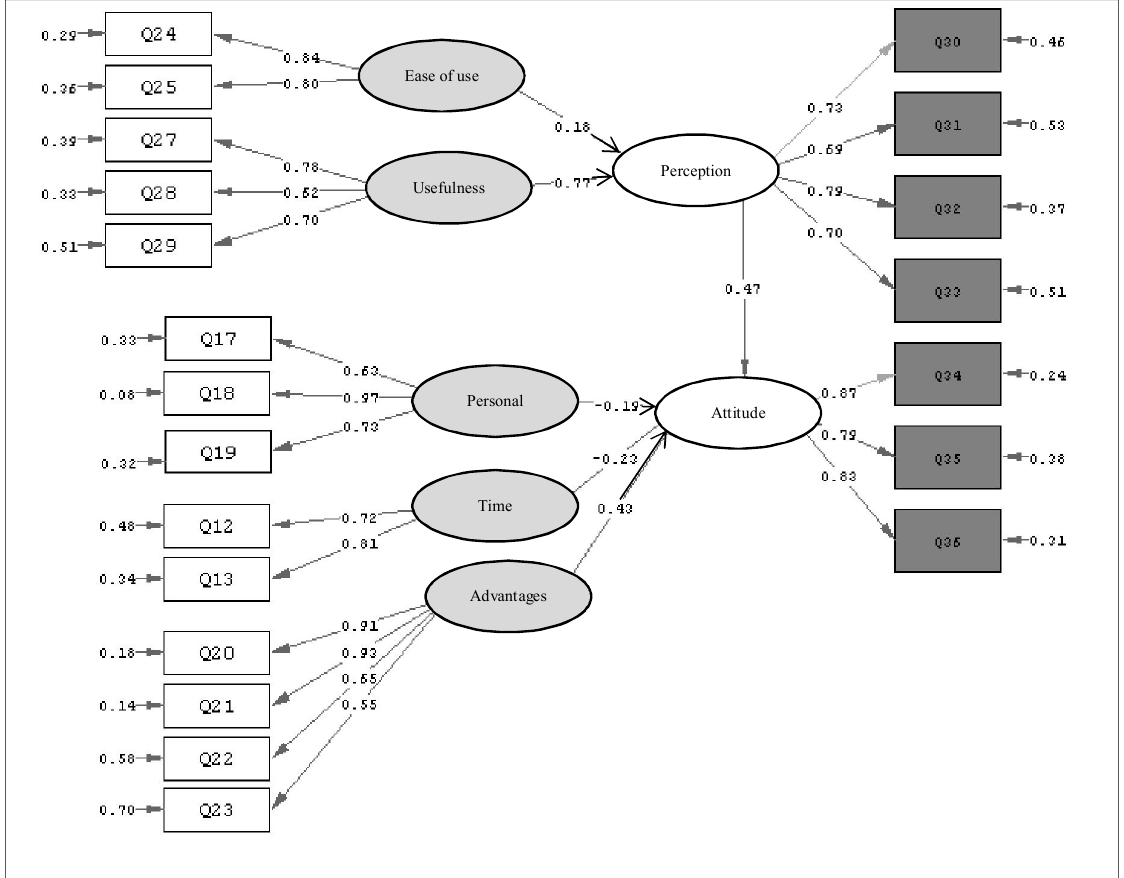
Fig. 3. The results of SEM implementation by LISREL